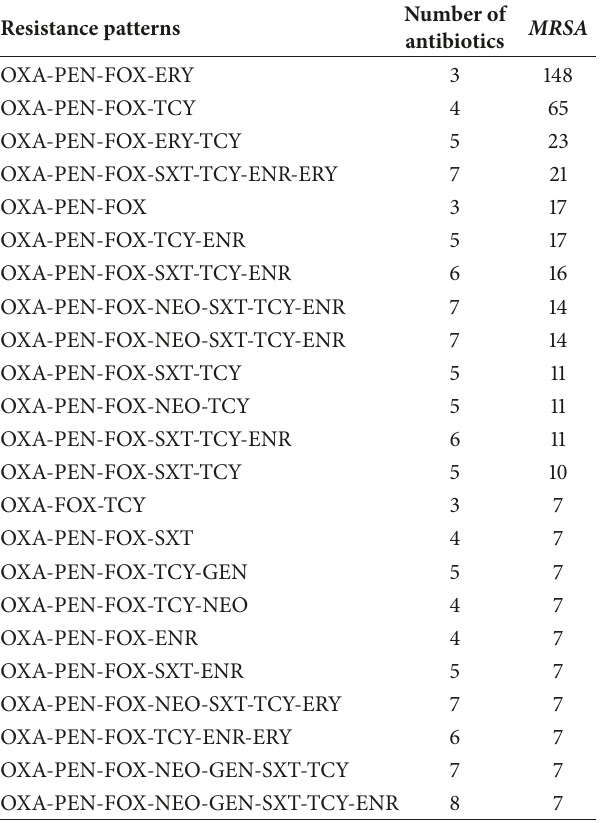
Table 6: Antibiotic resistance patterns of MRSA isolated from bovine